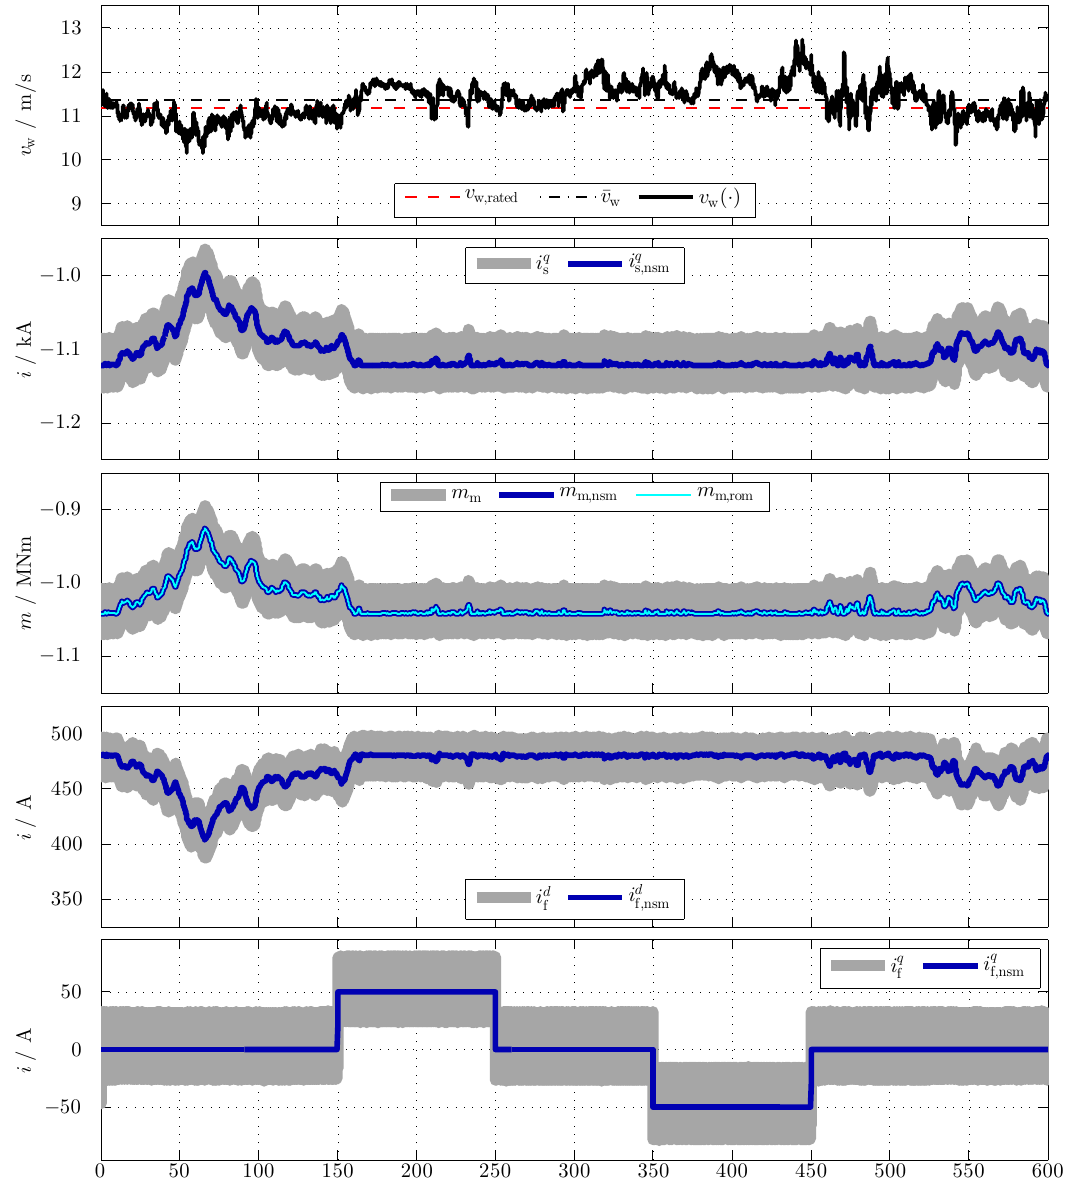
Figure 12. Comparison of torques, and machine-side and filter-side currents (if available in